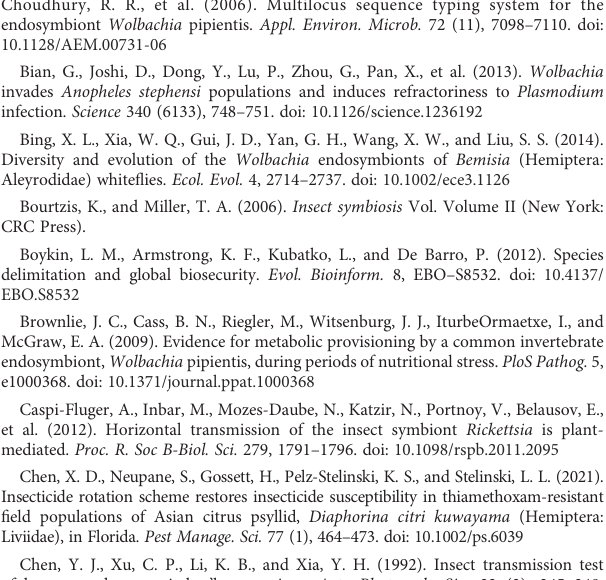
SUPPLEMENTARY FIGURE 1 The phylogenetic relationships of Wolbachia from different insect hosts based on the DNA sequence of (A) coxA , (B) fbpA , (C) ftsZ , (D) gatB and (E) hcpA gene. The tree was constructed and analyzed by Neighbor-Joining (NJ) method using 1000 bootstraps